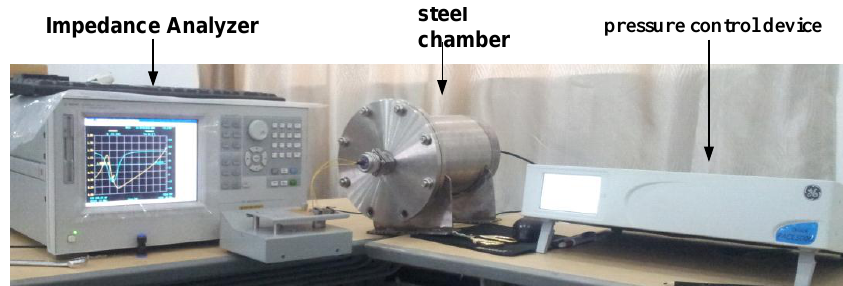
Figure 8. Frequency-pressure measurement system.